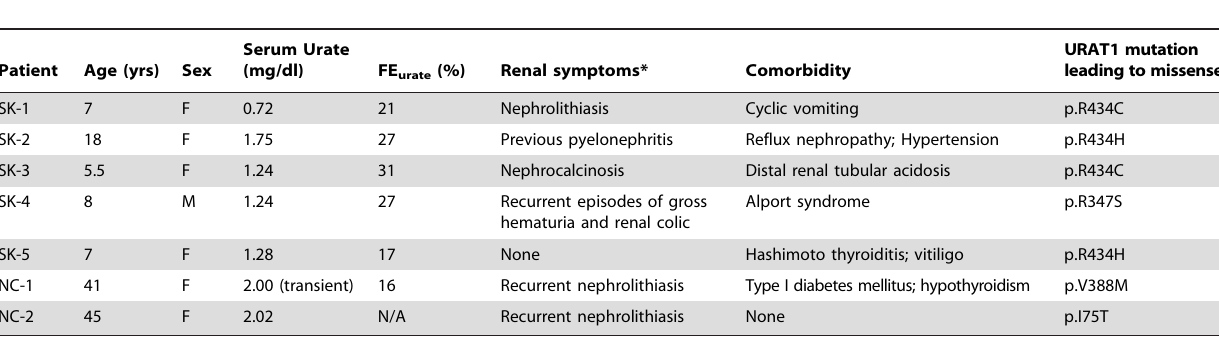
Table 1. Demographic, clinical, biochemical and molecular genetic data on 6 patients with renal hypouricaemia.